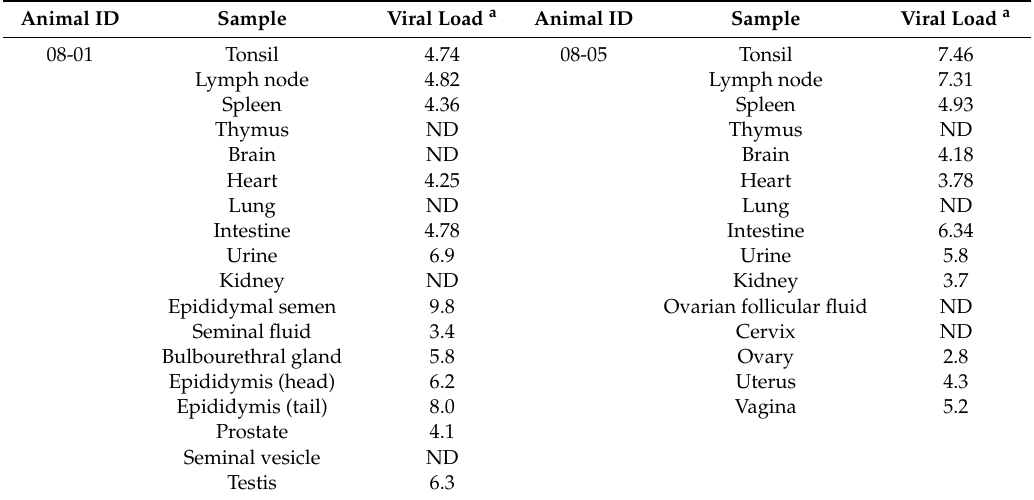
Table 2. Quantity of Bungowannah virus RNA detected in selected tissues and fluids from pigs 8-01 and 8-05 (D55 Ab − ve) at 11 months of age.